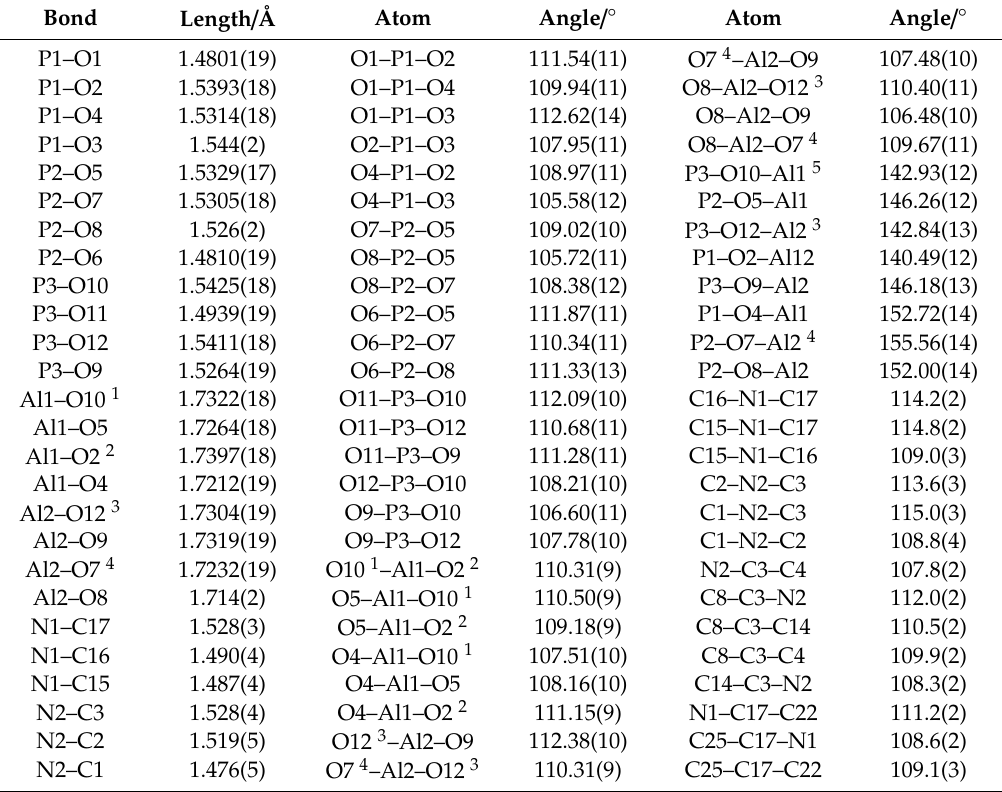
Table 4. Selected bond lengths and angles for SYSU-6.